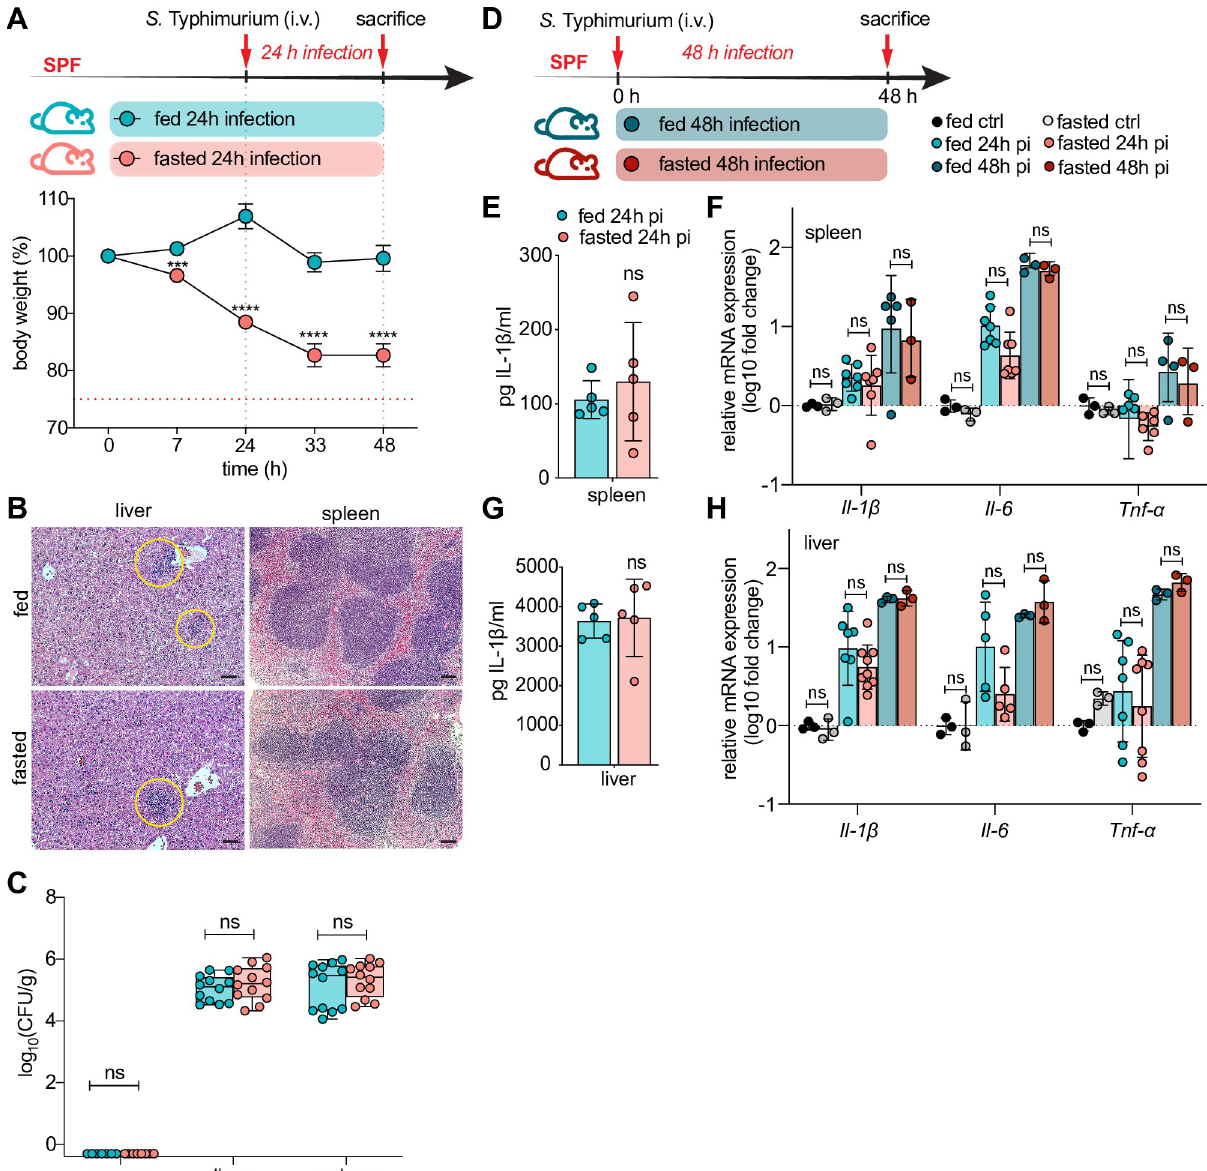
Fig 2. Fasting does not limit systemic S . Typhimurium infection. (A, D) Experimental timeline of infection and fasting regimen (applicable to all data shown in this figure) and concurrent body weight loss. SPF C57BL/6 mice were i . v . (tail vein) injected with ~ 5 × 10 4 CFU S . Typhimurium and sacrificed at 24h p.i. (A) (n = 12) or 48h p.i. (D) (n = 6) (B) Representative H&E-stained liver and spleen sections of mice i . v . infected with S . Typhimurium at 24h p.i. ± 48h of fasting. Yellow circles indicate accumulation of granulocytes. Scale bar 50 μ m. (C) S . Typhimurium CFU per g tissue 24h p.i. (see Fig 2A for experimental timeline). (E, G) IL-1 β protein levels measured by ELISA in spleen and liver lysates of mice i . v . infected with S . Typhimurium at 24h p.i. ± 48 h of fasting. (F, H) qPCR analysis of inflammatory genes in mouse spleen (F) and liver (H) expressed as fold change over fed ctrl. Fed ctrl and fast ctrl refer to uninfected ad libitum fed or 48h fasted C57BL/6 SPF mice. All data shown repeated in 3 independent experiments. For (C), (F) and (H) data from multiple independent experiments were pooled. ���� p < 0.0001, ��� p < 0.001, ns = not significant. Significance levels calculated by unpaired Student’s t test (E, G), multiple t-test (A) and Mann-Whitney-Wilcoxon test (C) with Holm-Sidak correction and 2-way ANOVA with Tukey post-test (F, H). Error bars shown as ± SD, except (C) which is shown as box plot with min-max whiskers.